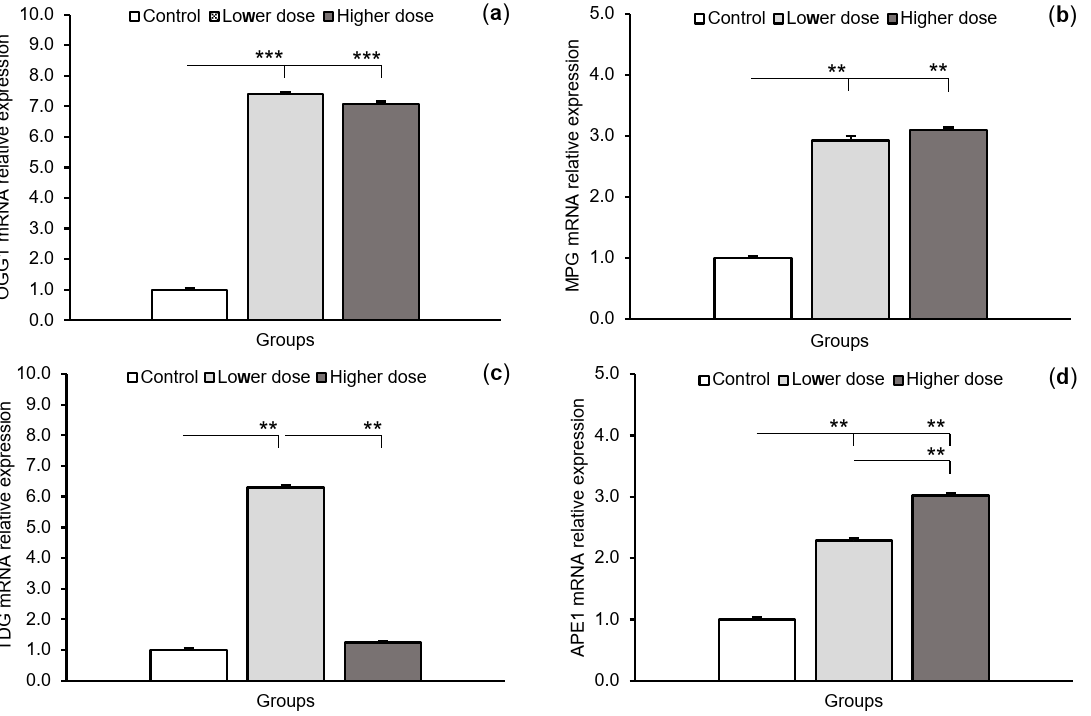
Figure 2. Tyrosine receptor kinase B (TrkB) mRNA expression (mean ± SEM) in the hippocampal CA1 field of sheep infused with the lower (20 μ g in total) and higher (100 μ g in total) dose of kynurenic acid into the third ventricle of the brain. Significance of differences: * p < 0.05, *** p < 0.001. 2.2. mRNA Expression and Activity of DNA Glycosylases The transcripts of all tested DNA glycosylases (OGG1, MPG, and TDG) and APE1 were detected in the CA1 field of the hippocampus. The relative abundance of these tran- scripts in all treatment groups is shown in Figure 3. A significant increase ( p < 0.01— p < 0.001) in mRNA expression for all glycosylases in the hippocampal CA1 field was ob- served after administration of the lower KYNA dose in comparison with controls. The response in terms of transcription of glycosylases to the higher dose was variable: KYNA stimulated the expression of OGG1 ( p < 0.001) and MPG mRNA ( p < 0.01), but had no effect on TDG mRNA expression compared to controls. Moreover, the abundance of OGG1 and MPG transcripts in the CA1 field did not differ between sheep treated with the lower and higher KYNA doses, while TDG mRNA levels in the lower dose-infused sheep were higher ( p < 0.01) than in the animals infused with the higher dose. The level of APE1 mRNA expression was dose-dependent: both lower and higher doses increased ( p < 0.01) transcript abundance in the CA1 field compared to the control animals, but APE1 mRNA infused with the higher dose was higher ( p < 0.01) compared to the animals infused with expression in sheep infused with the higher dose was higher ( p < 0.01) compared to the the lower dose. animals infused with the lower dose.